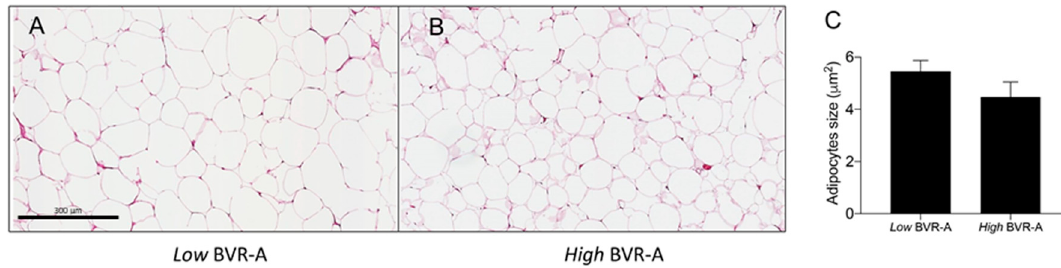
Figure 2. IL-8, Caspase 3 ( A ), IL-6 and TNF- α ( B ) mRNA expression levels in VAT relatively to BVR-A Figure 2. IL ‐ 8, Caspase 3 ( A ), IL ‐ 6 and TNF ‐α ( B ) mRNA expression levels in VAT relatively to BVR ‐ mRNA expression levels. Subjects were dived into two groups based on BVR-A mRNA expression A mRNA expression levels. Subjects were dived into two groups based on BVR ‐ A mRNA expression levels below or above the median value (low and high BVR-A, respectively). Data are expressed as levels below or above the median value (low and high BVR ‐ A, respectively). Data are expressed as mean ± SEM, * p < 0.05 (Mann–Whitney). A.U., arbitrary units. mean ± SEM, * p < 0.05 (Mann–Whitney). A.U., arbitrary units.